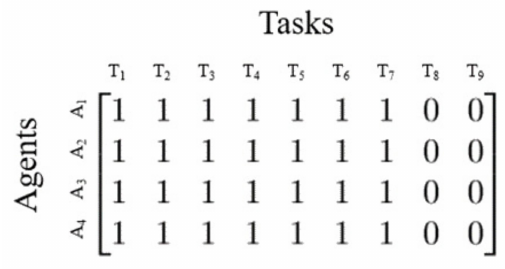
Figure 19. Transfer Matrix (TM) for the